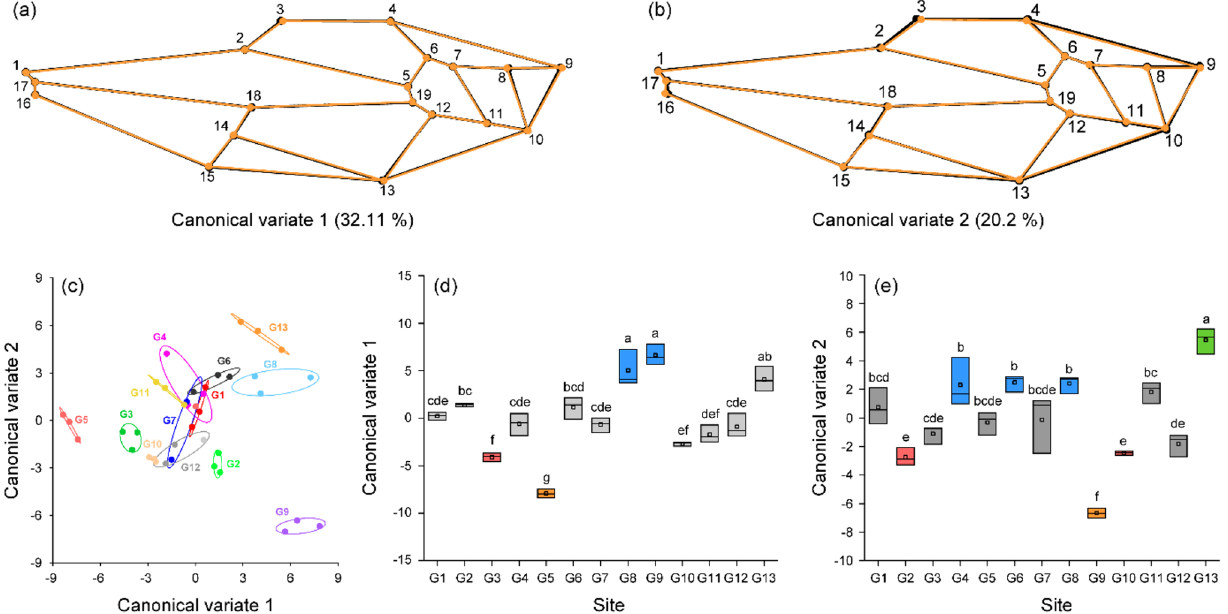
Figure 5. Canonical variate analysis (CVA) and wireframe graph with 19 landmarks illustrating morphological variance in wing shape among yellow-legged hornet from 13 sites: ( a ) wireframe graph illustrating minor morphological differences based on canonical variate 1 (CV1). ( b ) Wireframe graph illustrating minor morphological variation based on CV2. The wireframe of black circle and line represents shape with minimum CV value in CV wireframe graph, and the wireframe of orange circle and line represents shape with maximum CV value. Morphological variations in the major axes CV1 and CV2 were hardly detected. ( c ) Scatterplots of CV1 and CV2 from CVA of 19 landmarks for 39 yellow-legged hornets from 13 sites. ( d ) Comparison of CV1 values among yellow-legged hornets from the 13 sampling sites. ( e ) Comparison of CV2 values among yellow-legged hornets from the 13 sampling sites. Lowercase letter and box color indicate significant differences ( p < 0.05) in CV1 and CV2 based on Tukey’s post hoc